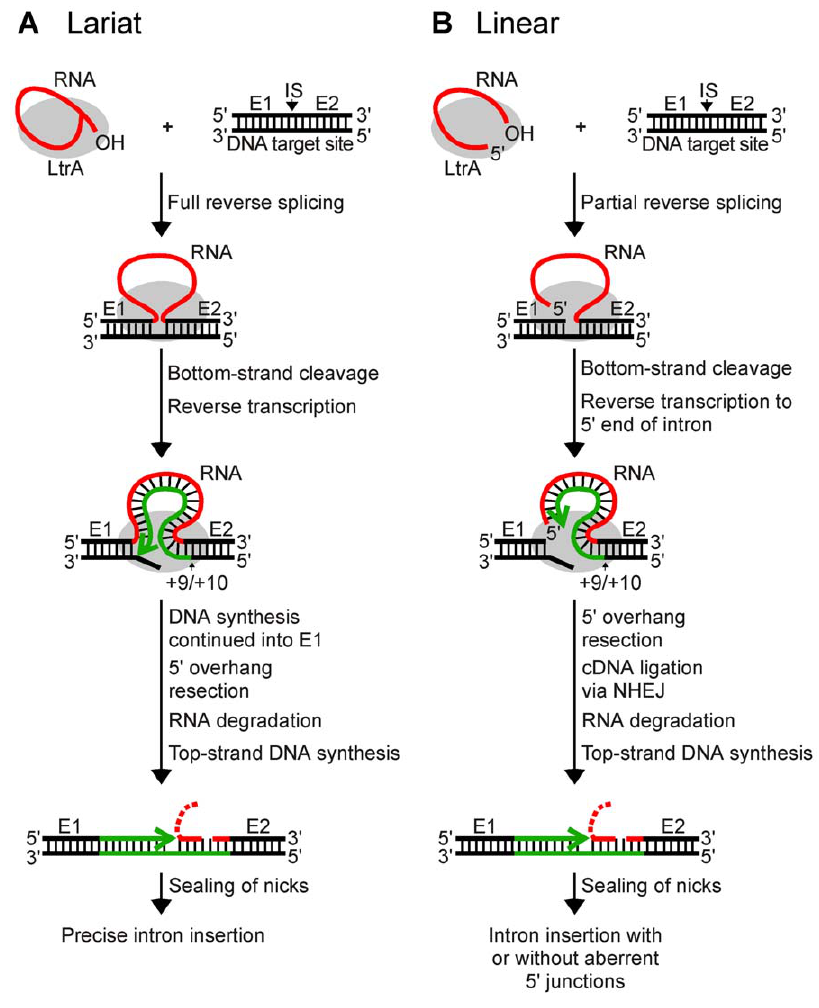
Figure 1. Models for retrohoming of Ll.LtrB group II intron lariat and linear RNAs. (A) Retrohoming of lariat RNA. RNPs containing lariat RNA recognize the DNA target site (ligated E1–E2 sequence) and carry out both steps of reverse splicing, resulting in insertion of the intron RNA between E1 and E2. The IEP uses its En domain to cleave the bottom strand between positions + 9 and + 10 of E2, and then uses the 3 9 end of the cleaved DNA strand as a primer for reverse transcription of the inserted intron RNA. The resulting full-length intron cDNA is extended directly into E1 by continued DNA synthesis. Retrohoming is completed by a process that includes removal of the 5 9 overhang on the bottom strand, degradation or displacement of the intron RNA template strand, top-strand DNA synthesis by a host DNA polymerase, and sealing of nicks by a host DNA ligase [21]. (B) Retrohoming of linear RNA. RNPs containing linear intron RNA recognize the DNA target site and carry out the first step of reverse splicing, resulting in ligation of the 3 9 end of the intron RNA to the 5 9 end of E2. The IEP then uses its En domain to cleave the bottom strand between positions + 9 and + 10, generating a primer for reverse transcription of the intron RNA, as in lariat RNA retrohoming. However, because the 5 9 end of the linear intron RNA is unattached, the resulting cDNA cannot be extended directly into E1 and is instead linked to the 5 9 exon DNA by an error- prone process that sometimes leads to precise insertion of the intron RNA, but often gives imprecise 5 9 junctions due to deletion of E1 sequences, 5 9 - intron truncations, and/or insertion of extra nucleotide residues at the ligation junction. As for lariat RNA, retrohoming of the linear intron RNA is completed by degradation or displacement of the intron RNA template strand, top-strand DNA synthesis, and sealing of nicks by host enzymes. E1 and E2, 5 9 and 3 9 exon, respectively; CS, bottom-strand cleavage site; IS, intron-insertion